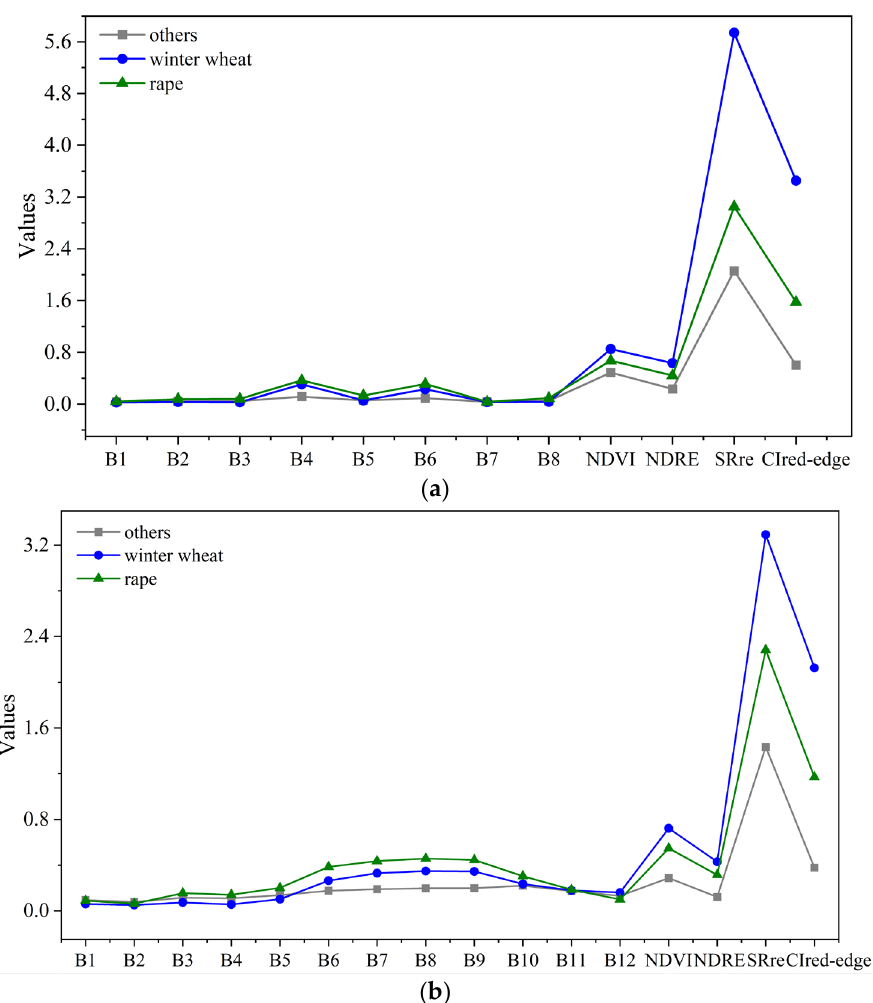
Figure 8. Analysis of various spectral vegetation index curves in ( a ) GF-6 WFV and ( b ) Sentinel-2A